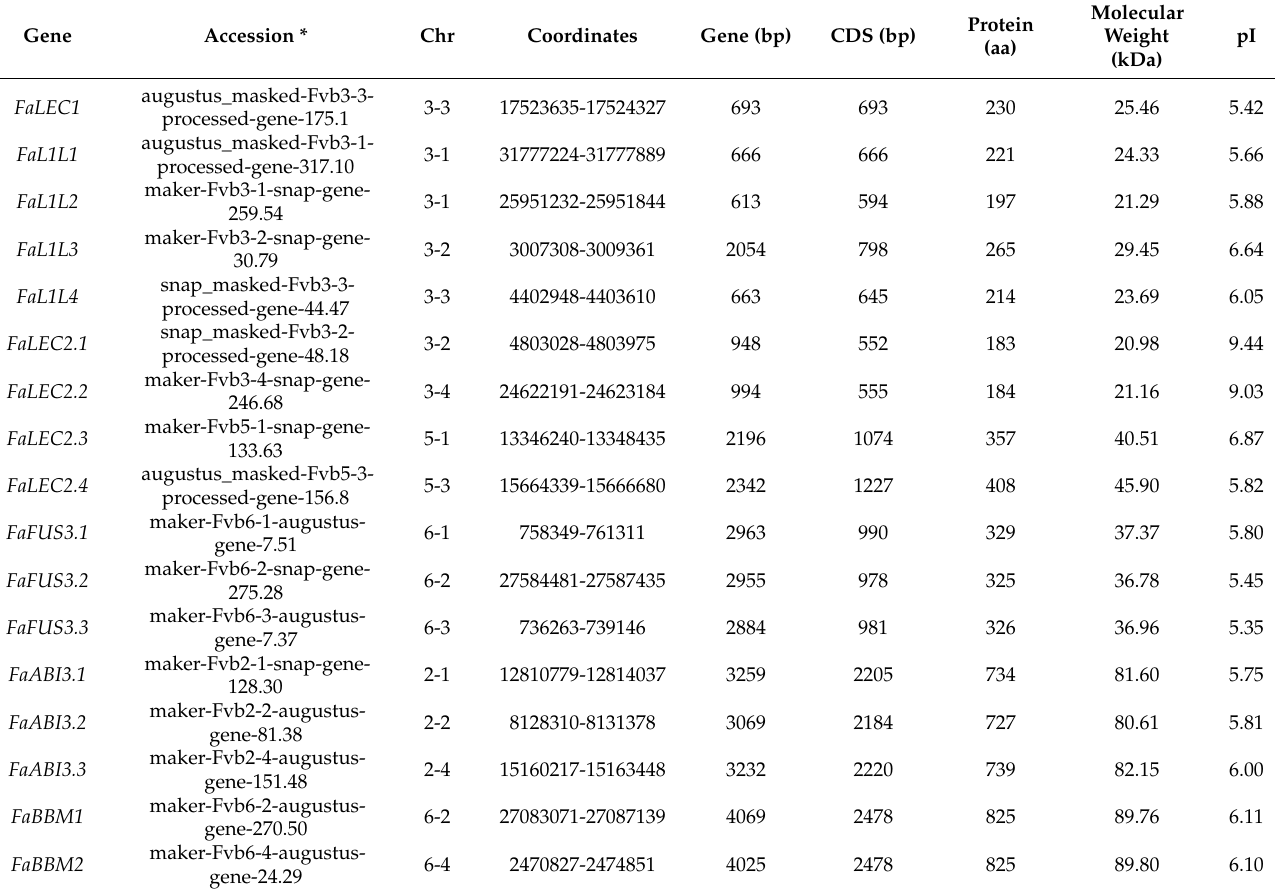
Table 1. Genomic data for LEC1 , LEC2 , FUS3 , ABI3, and BBM genes in Fragaria × ananassa .